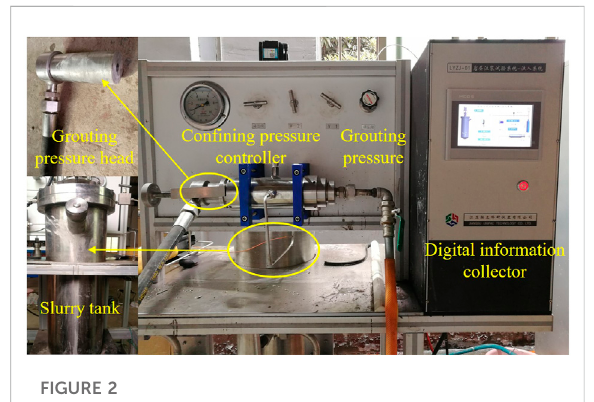
FIGURE 2 Rock strata grouting test